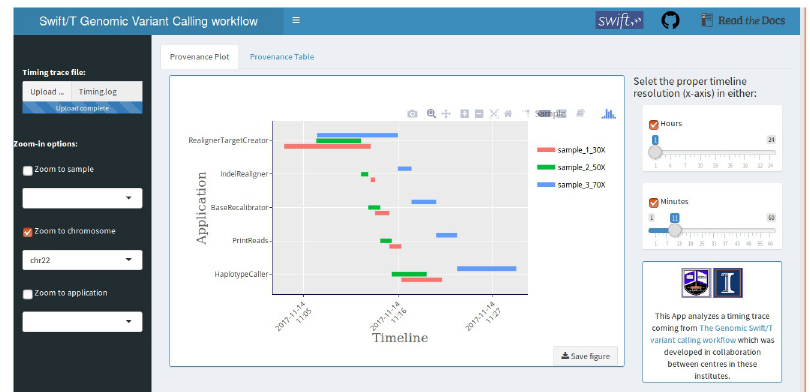
Fig 2. Timing provenance tracking of a 3-sample pipeline run (synthetic whole exome sequencing dataset at 30X, 50X and 70X) on Biocluster [50]. This plot view is interactive, allowing full pan and zoom and was generated using plotly library in